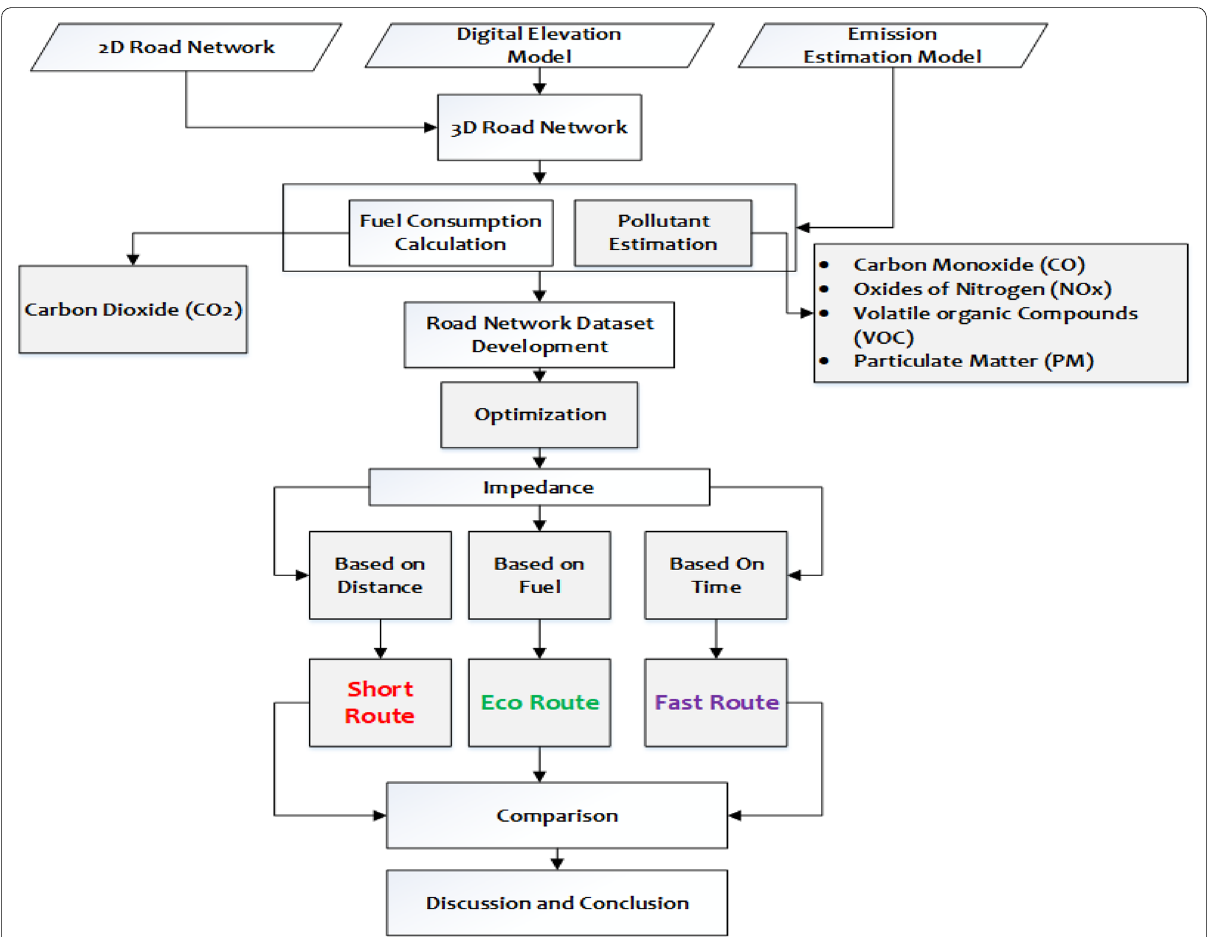
Fig. 2 General work flow of the